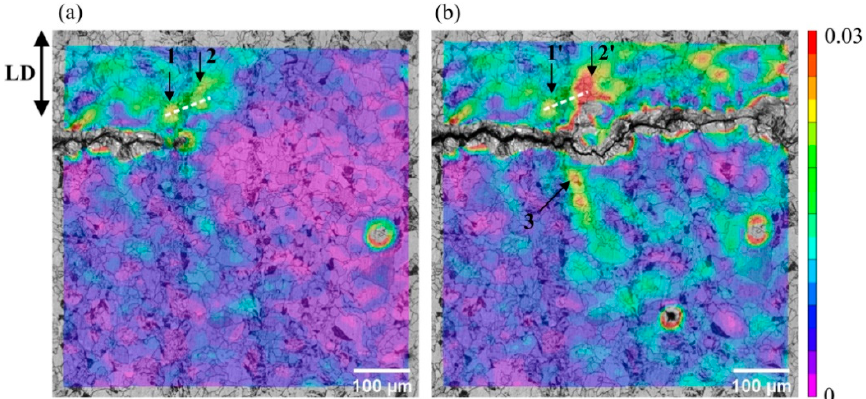
Figure 10. von Mises strain fields of the LD1 specimen under a 20× objective lens: ( a ) a = 1.75 mm, N = 95,000 cycles; ( b ) a = 2.15 mm, N = 100,000 cycles.